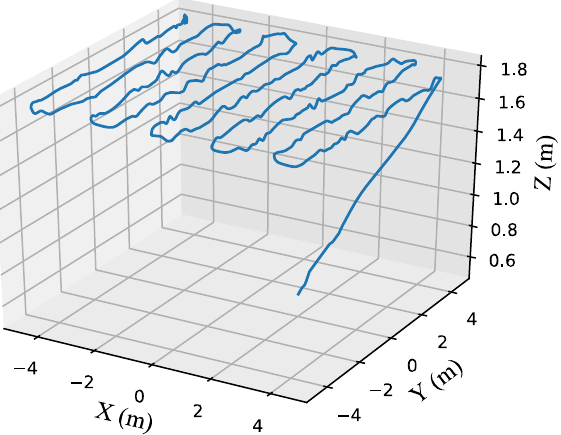
Figure 6. Real flight path of the quadrotor in the time-varying wind field.